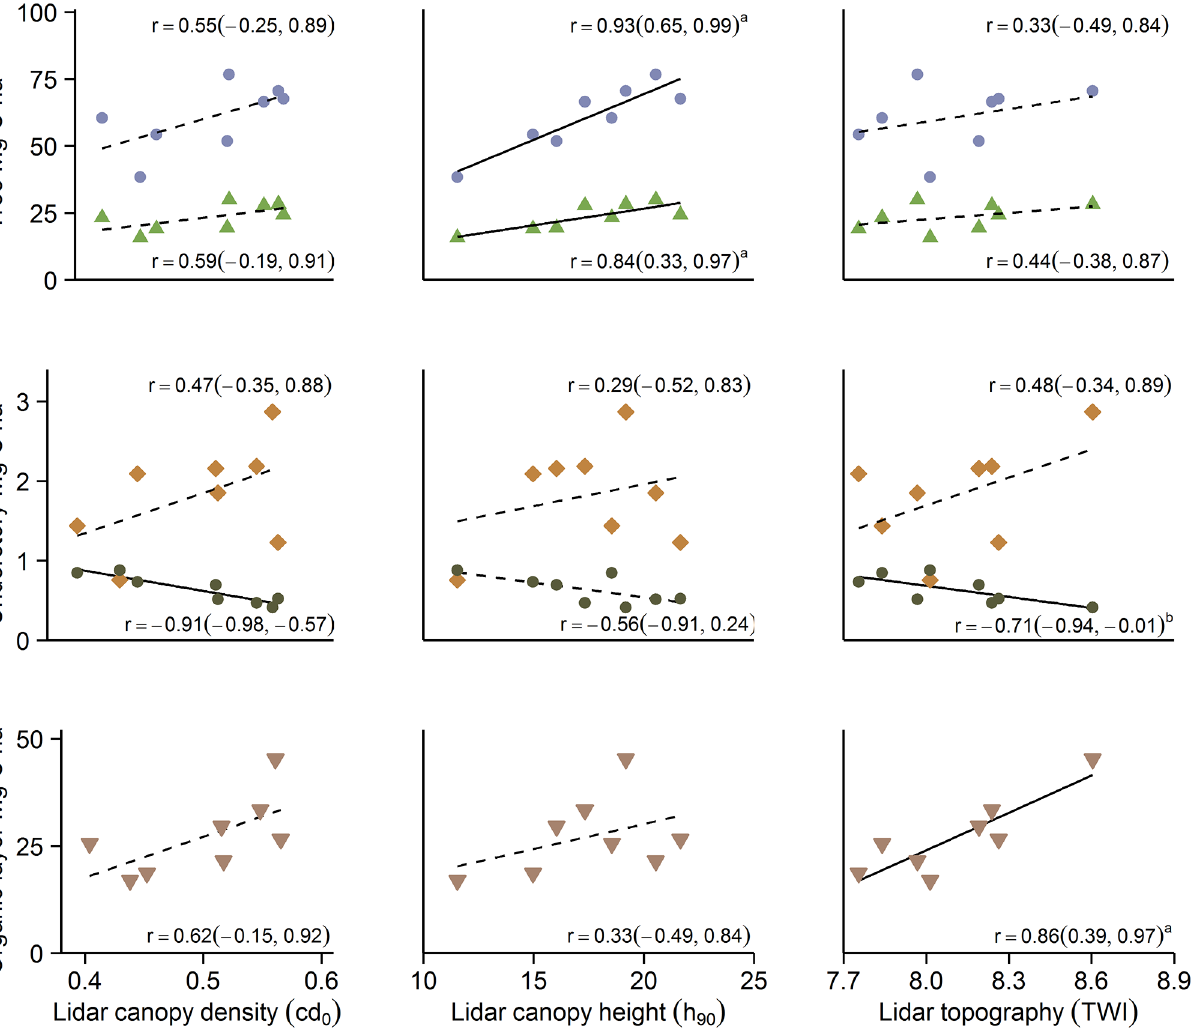
Fig 7. Relationship between lidar plot data and forest C compartments. Pearson ’ s correlation (two-tailed) of five forest C compartments and three lidar variables for the plots used in this study (n = 8). Top row show aboveground (filled circles) and belowground (filled triangles) C stocks, second row show mosses (filled squares) and field layer (filled circles) C stocks, while bottom row represent organic layer C stocks (filled triangles). Full line indicate a significant correlation (level of significance is indicated by subscript letter ( a : p < 0.01, b : p < 0.05), while the dotted line show non-significant